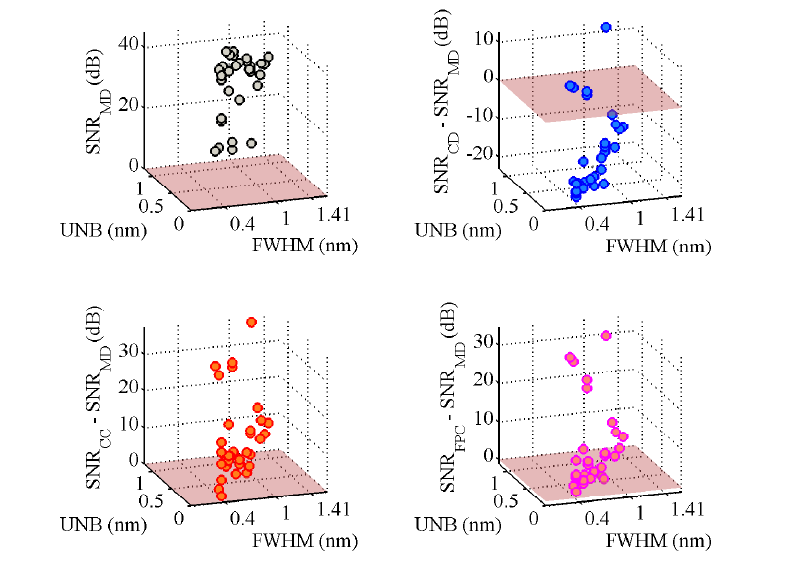
Figure 12. Performance evaluation of the demodulation algorithms based on experimental SNR levels. The maximum detection (MD) algorithm is taken as reference ( upper-right , bottom ). The FPC ( bottom-right ) performs better than the other